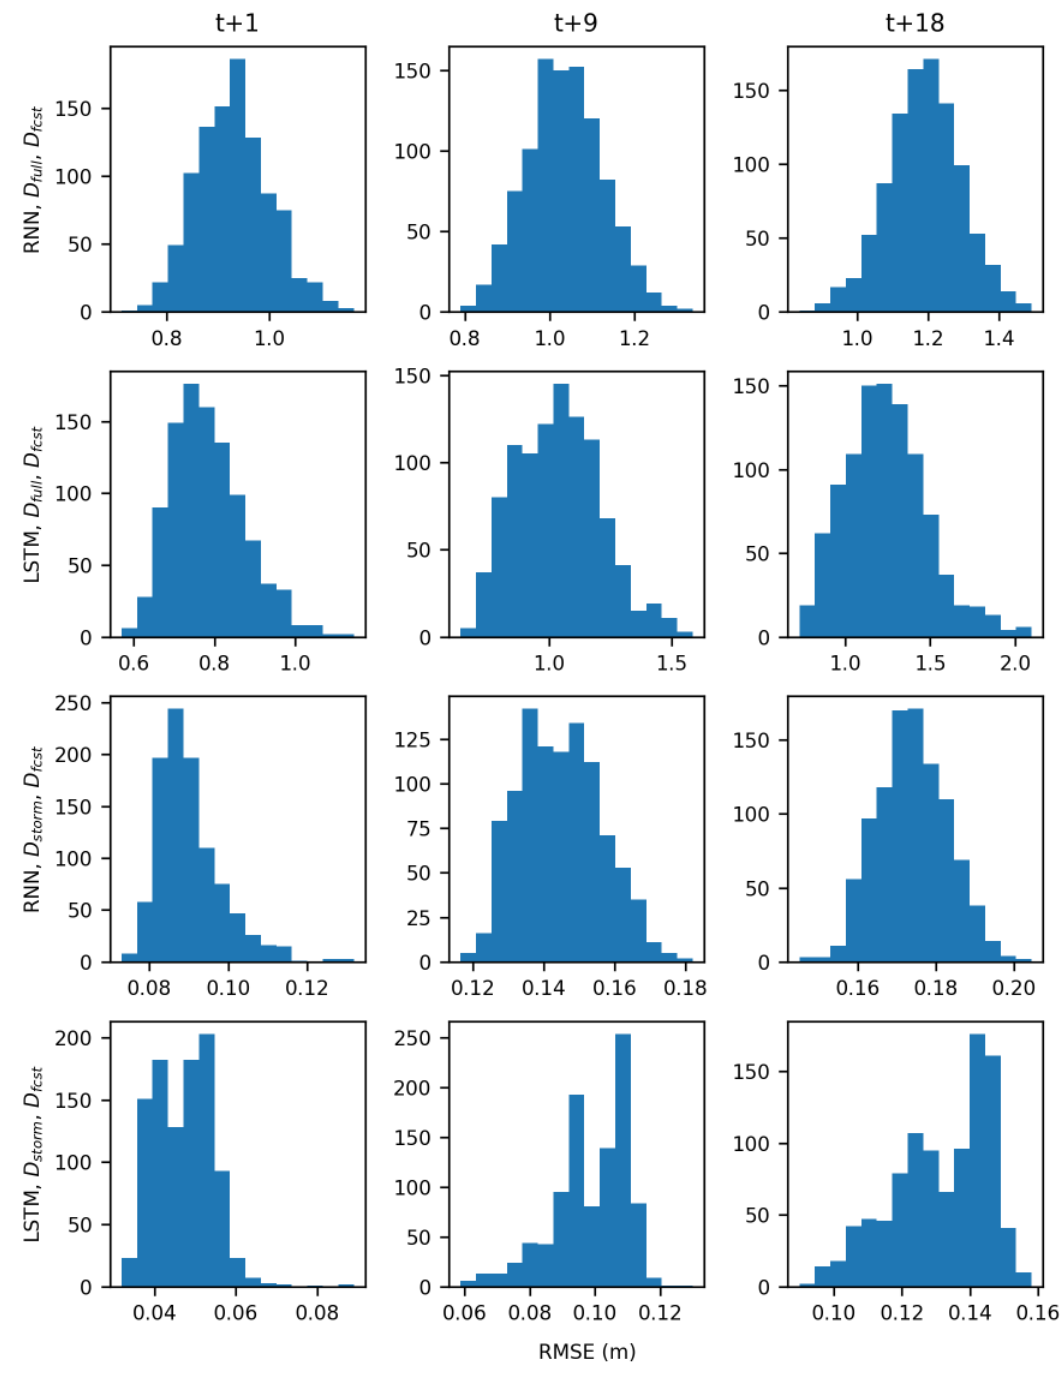
Figure A10. RMSE distributions for GW3 using forecast input data. Columns represent the forecast horizons t + 1, t + 9, and t + 18. Rows are specified as model type, training data, and testing data.